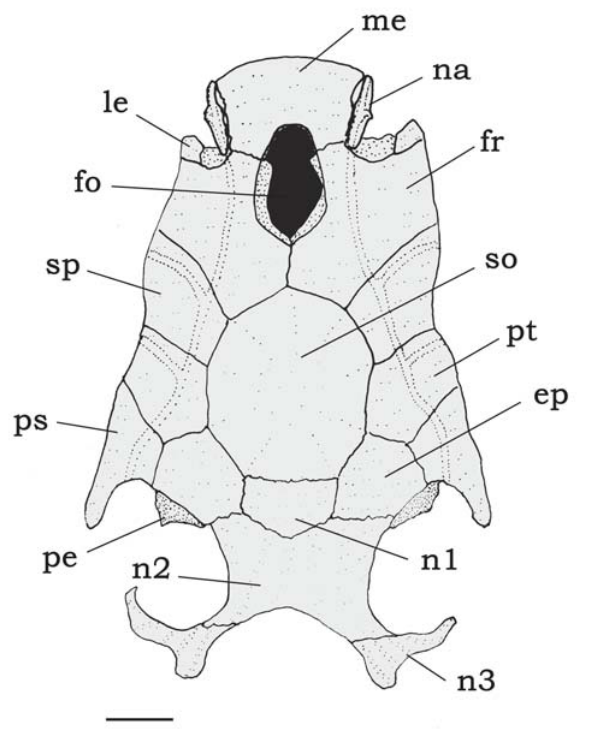
Fig. 28. Neurocranium of Tatia intermedia , MZUSP 44255, 65.5 mm SL. Dorsal view. Abbreviations: ep , epioccipital; fo , single cranial fontanel, fr , frontal; le , lateral ethmoid; me , mesethmoid; na , nasal; n1 , first nuchal plate, n2 ; second nuchal plate; n3 , third nuchal plate; pe , posterior epioccipital process; ps , posttemporal-supracleithrum; pt , pterotic; so , supraoccipital; sp , sphenotic. Scale bar = 1